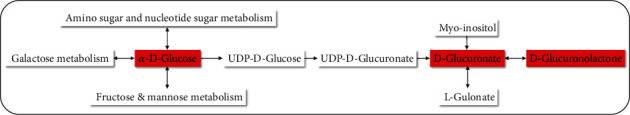
Effect of exogenous sucrose application (+S/-S) on ascorbate and aldarate metabolism in L13 and T3 soybean genotypes' roots under P starvation conditions (-P).